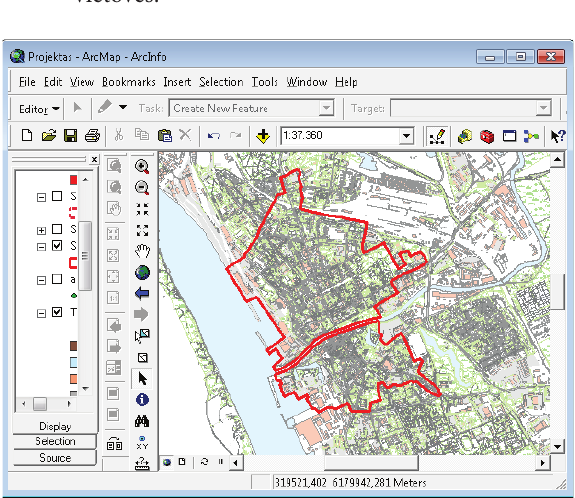
Fig. 1. The fragment from database VDB10-Klaipėda – the Old city borders